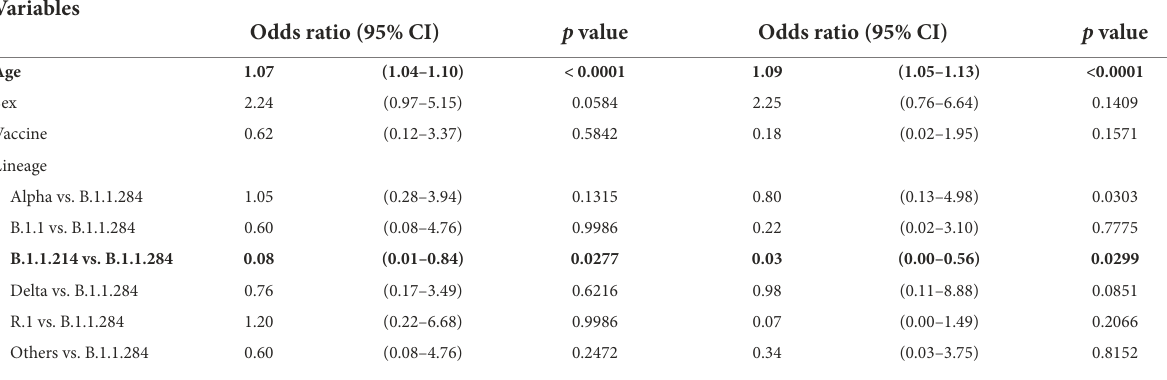
TABLE 4 Association between genotype and risks of severity in COVID-19 patients.